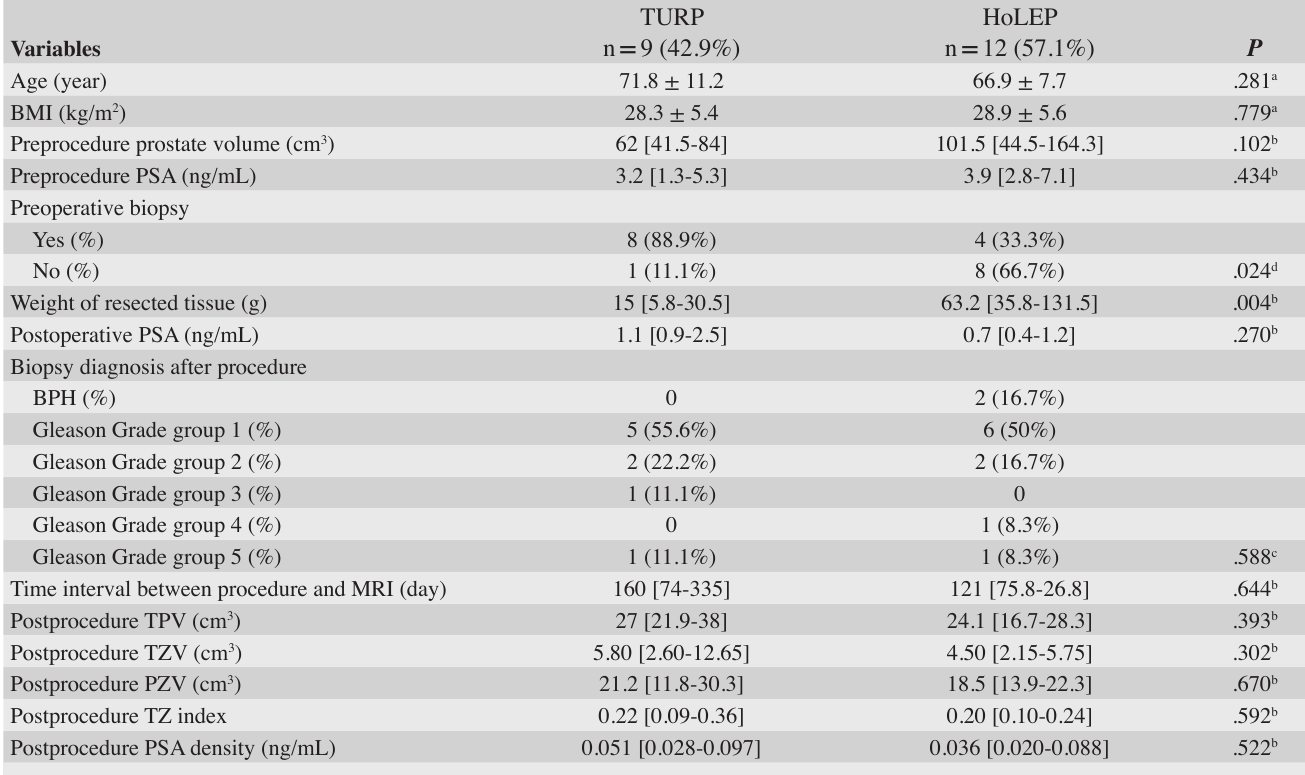
Table 1. Comparison of the Perioperative Variables Between Patients Who Underwent TURP Versus HoLEP Variables